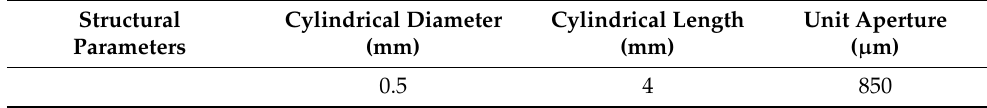
Figure 1. ( a ) BCC structural unit, ( b ) pore diameter of porous bone scaffold, and ( c ) finite element analysis model. Table 2. Parameters of BCC structure model.